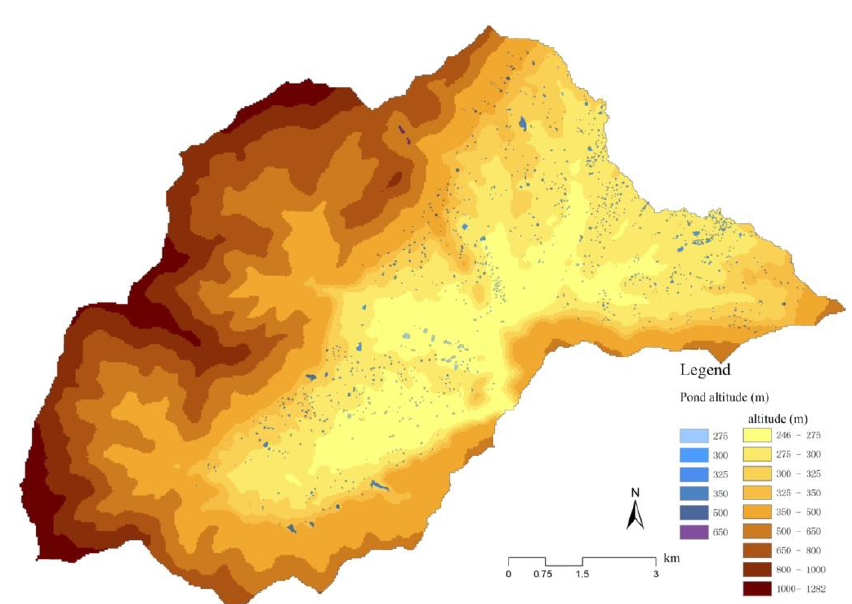
Figure 7. The altitude of the Beitang landscape.